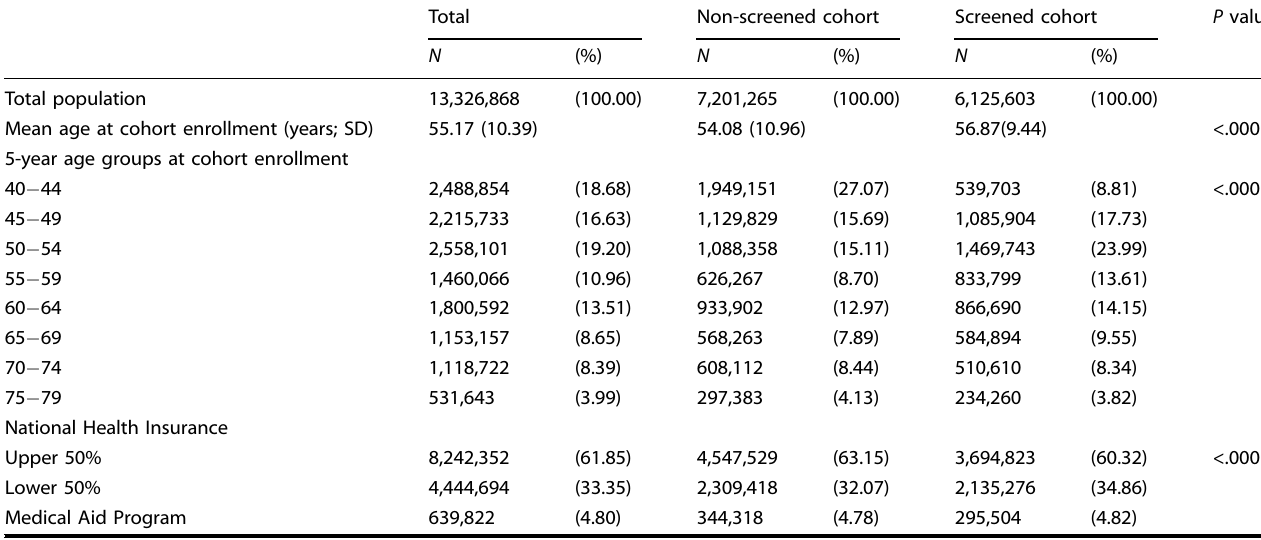
Table 1. Baseline characteristics of the screened and non-screened cohorts in the KNCSP for breast cancer, Republic of Korea. Total Non-screened cohort Screened